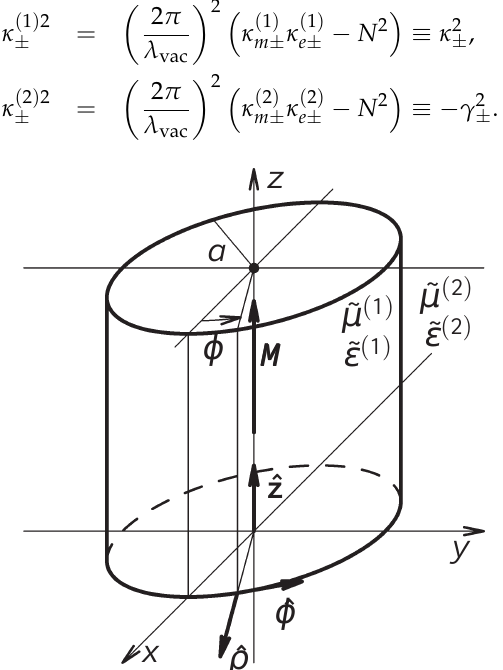
Figure 1. Dielectric circular cylindrical waveguide with the axial magnetization, M , in a circular cylinder coordinate system with the unit vectors ˆ (cid:36) , ˆ ϕ , and ˆ z . A field point is specified by (cid:36) = ϕ , and z . The core region of the radius a , (cid:36) tensors, ˜ µ ( 1 ) and ˜ ε ( 1 ) . The cladding region, (cid:36) tensors, ˜ µ ( 2 ) and ˜ ε ( 2 )